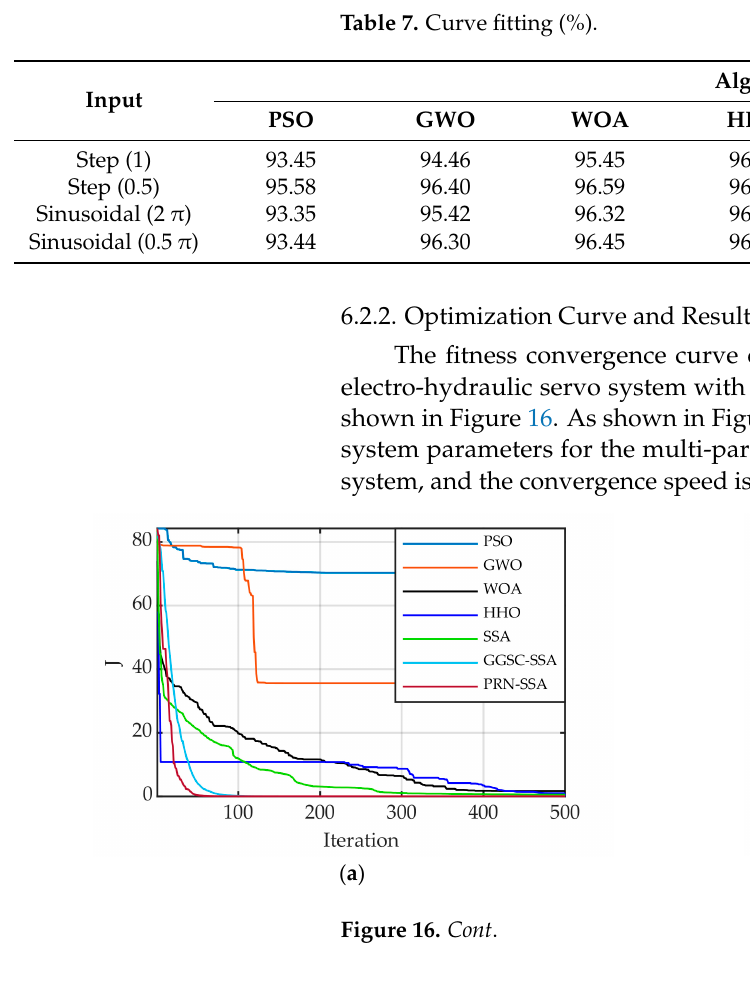
Figure 15. Partially enlarged view of wave peak (sinusoidal input): ( a ) Period is 2 π ; ( b ) Period is 0.5 π